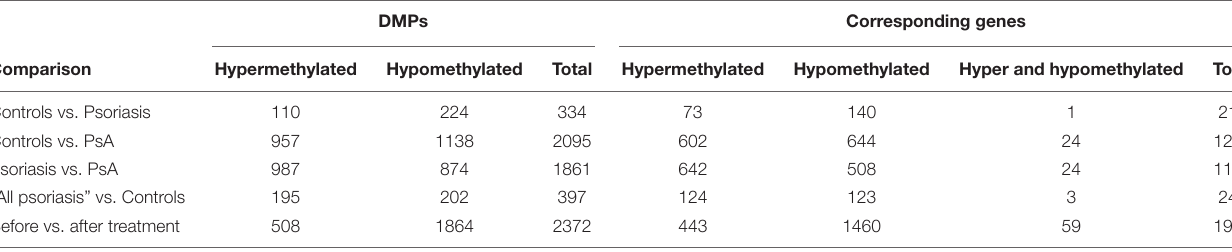
TABLE 2 | Differentially methylated positions (DMPs) in CD8 + T cells from psoriasis patients and controls. DMPs Corresponding